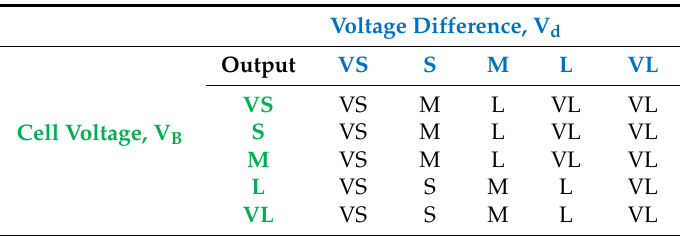
Table 1. Rule base for linguistic variables. VS, S, M, L, and VL are very small, small, medium, large and very large respectively.